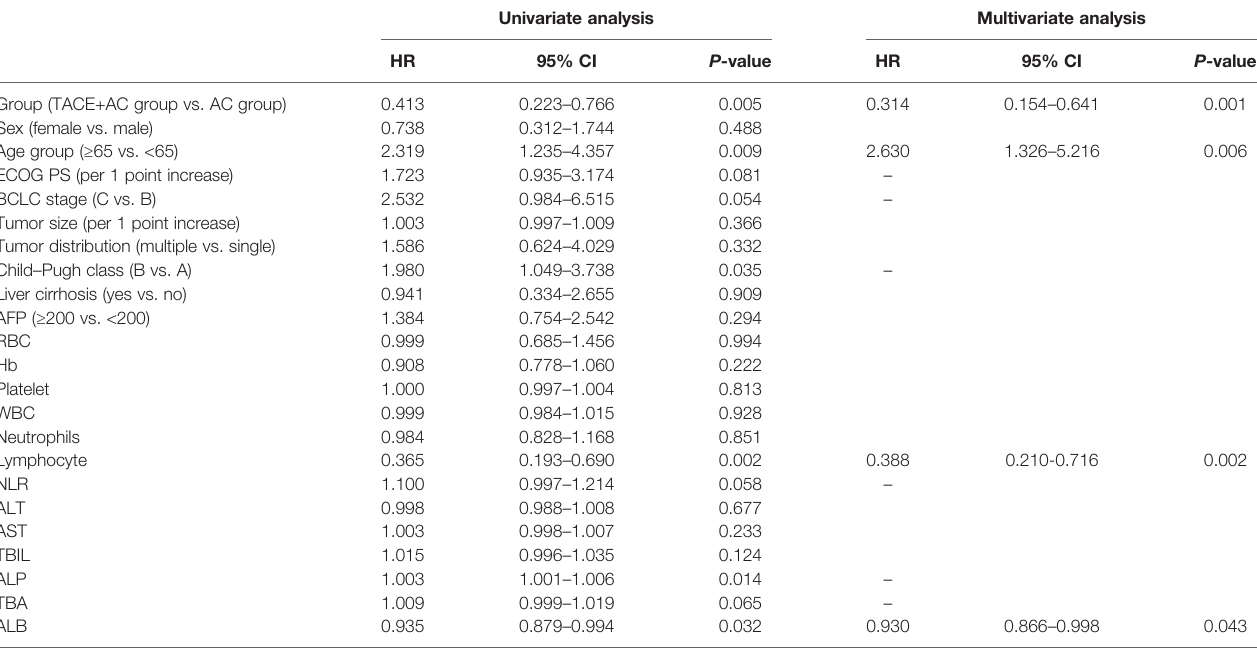
TABLE 2 | Univariate Cox proportional hazards regression model analysis for OS. Univariate analysis Multivariate